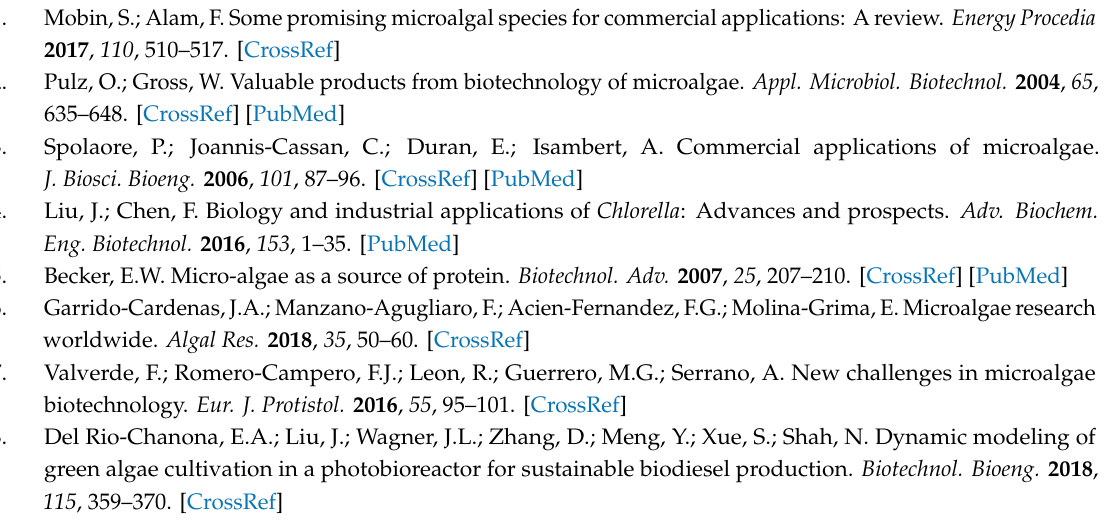
Supplementary Materials: The following are available online, Figure S1: Colchicine and cytochalasin B-mediated e ff ect on cell size, population heterogeneity and DNA content in the microalga Planktochlorella nurekis . (a,b) Cell morphology (here cell size) was analyzed using bright field (BF, Ch01, 435–480 nm; Ch09, 570–595 nm) using Amnis ® FlowSight ® imaging flow cytometer and IDEAS software (Merck Millipore). Five subpopulations of cells were considered, namely R1 (cells sized ranging from 5 to 10 µ m), R2 (cells sized ranging from 1 to 5 µ m), R3 (cells sized ranging from 10 to 15 µ m and autosporangia), R4 (cell aggregates sized over 15 µ m) and R5 (dividing cells with autospores) [%]. Representative dot plots and cell images are presented. Other channels are also shown, namely Ch02 (480–560 nm), Ch03 (560–595 nm), Ch04 (595–642 nm), Ch05 (642–745 nm) and Ch06 (745–780 nm). The auto-fluorescence reflects the content of various pigments. (c) Fluorescence microscopy-based analysis of DNA content. Cells were analyzed using an Olympus BX61 fluorescence microscope equipped with a DP72 CCD camera and Olympus CellF software (Olympus). For DNA visualization, the slides were counterstained with a drop of mounting medium containing 4 (cid:48) ,6 (cid:48) -diamino-2-phenylindole (DAPI) (blue). DNA content was expressed as arbitrary units [a.u.]. Representative microphotographs and data distribution (histograms) are shown. Figure S2: Colchicine and cytochalasin B-mediated e ff ect on lauric acid, myristic acid, pentadecanoic acid, palmitic acid, stearic acid, arachidic acid, oleic acid and linoleic acid in the microalga Planktochlorella nurekis . Correlation analysis between lauric acid, myristic acid, pentadecanoic acid, palmitic acid, stearic acid, arachidic acid, oleic acid and linoleic acid and DNA content. Twelve CC-treated clones were considered (black dots). WT cells are denoted as a red dot. Results represent the mean from three independent experiments. The levels of selected fatty acids were calculated per 100 g of dry weight. The 95% confidence interval is shown. Correlation analysis of the data was performed using a Linear Correlation (Pearson r) test. DW, dry weight. Figure S3: Colchicine and cytochalasin B-mediated e ff ect on the levels of essential amino acids (top) and non-essential amino acids (bottom) in the microalga Planktochlorella nurekis . Correlation analysis between essential amino acids, non-essential amino acids and DNA content. Twelve CC-treated clones were considered (black dots). WT cells are denoted as a red dot. Results represent the mean from three independent experiments. The levels of amino acids [mg] were calculated per g of dry weight. The 95% confidence interval is shown. Correlation analysis of the data was performed using a Linear Correlation (Pearson r)